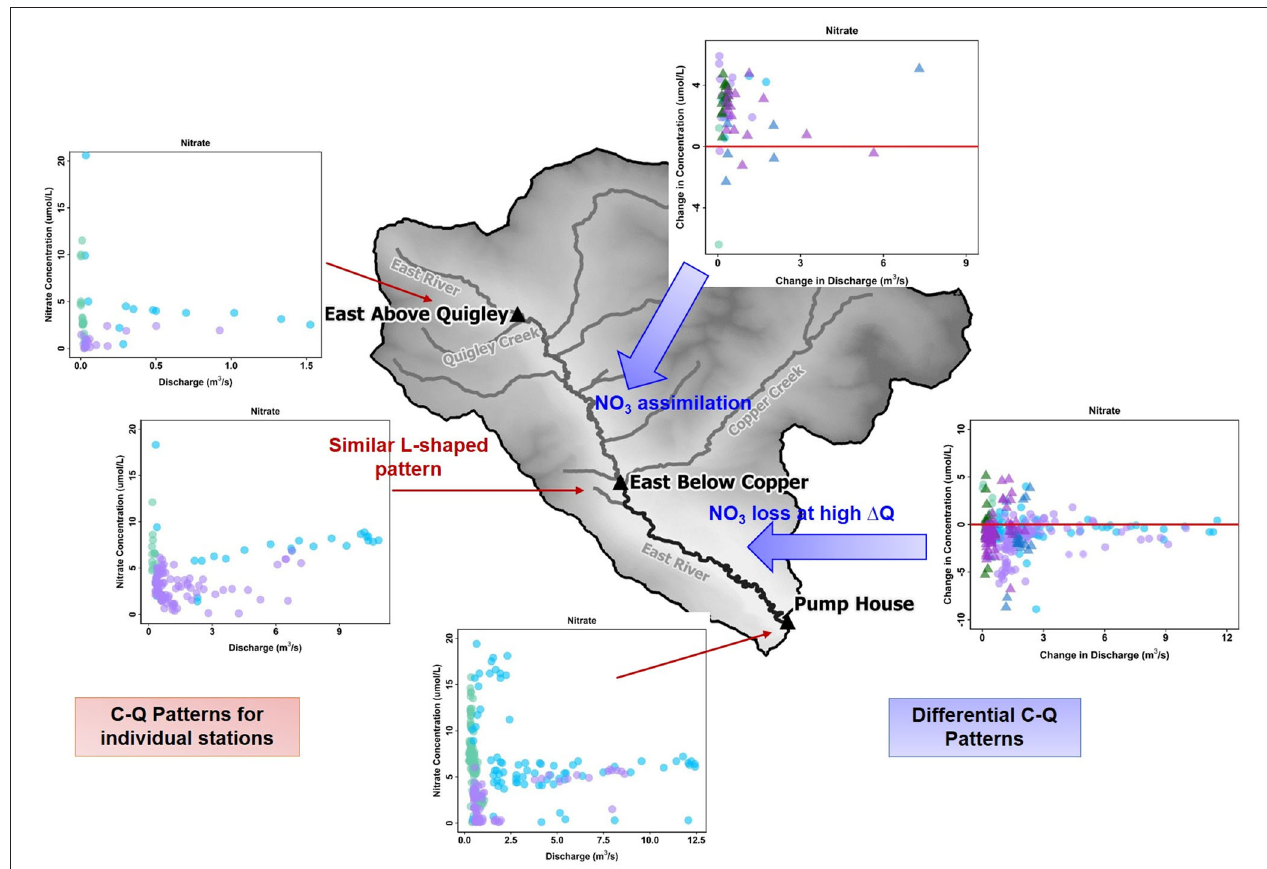
FIGURE 9 | A comparison of C-Q hysteresis patterns for NO 3 across individual stations and differential C-Q analyses across the upstream and downstream reaches encompassing those stations. The C-Q patterns show a consistent L-shaped pattern for NO 3 across all three stations of the East River Catchment. In comparison, differential C-Q metrics show gains in nitrate in the upstream reach and losses in the downstream reach during high gains in discharge.